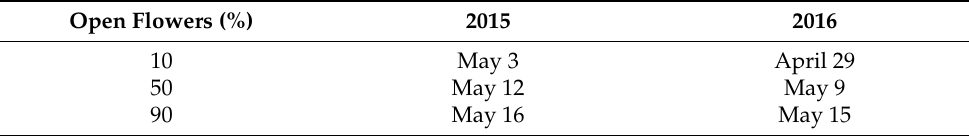
Table 3. Blooming phenogram of ‘Lecciana’ in two subsequent seasons. Full bloom corresponds to the date with 50% of open flowers.